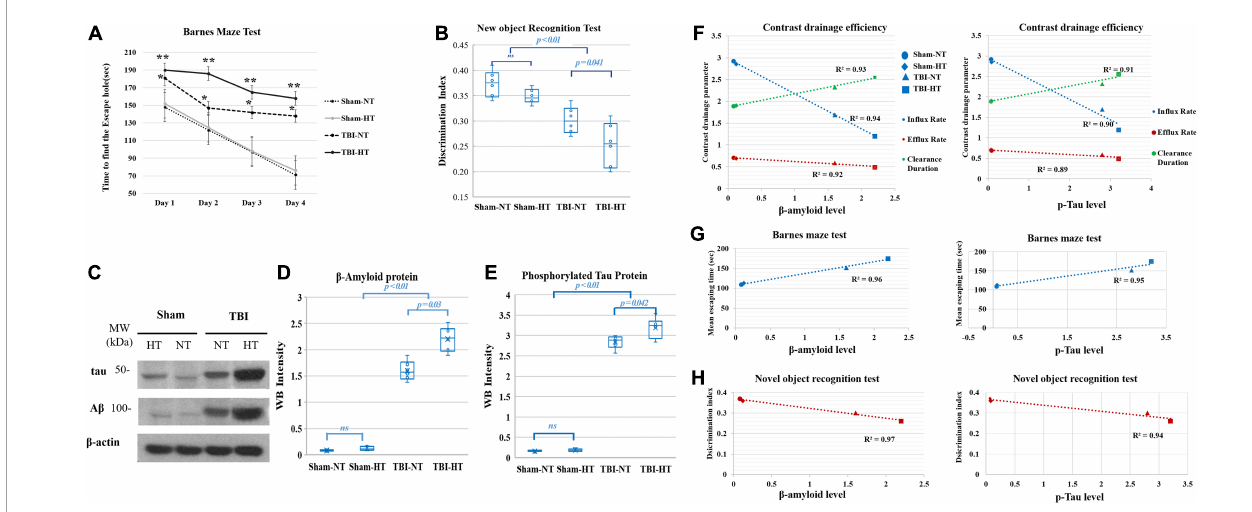
FIGURE6 Cognitive function was evaluated with the novel-object recognition test (A) and the Barnes maze test (B) . In both trials, TBI-HT and TBI-NT rats showed impaired cognitive performance compared with sham controls (* p < 0.05, TBIs vs. sham and TBI-HT vs. TBI-NT, n = 8–12 animals per group). Posttraumatic cognitive impairment was exacerbated in the hypothermic TBI rats compared with the normothermic TBI rats (** p < 0.05 TBI-HT vs. TBI-NT, n = 12 animals per group). (C) Western blot analysis shows obvious beta-amyloid and p-tau accumulation in rat brains 1 month after TBI and hypothermia. Quantitative analysis shows significantly increased β -amyloid (D) and p-tau (E) deposition in TBI-HT and TBI-NT rats compared with sham controls (Mean ± SD, one-way ANOVA with Bonferroni’s post-hoc test for multiple comparisons; n = 4–6 animals per group, n.s.: not significant). The correlation between p-tau and β -amyloid accumulation with glymphatic dysfunction and cognitive deficits is described in box plot graphs (F–H) . Box plot graphs (F) show that the amyloid β and p-tau levels in the brains of sham control, TBI-NT, and TBI-HT rats were inversely linearly related to the reduced influx and efflux rate and linearly related to the increased clearance constant of high-molecular-weight contrast transported along with perivascular spaces (pineal and pituitary recess and periarterial space of the olfactory artery) in the four groups ( r 2 = 0.94, 0.92, 0.93 for amyloid β level and r 2 = 0.90, 0.89, 0.91 for tau level and the influx rate, efflux rate and clearance constant, respectively, all p < 0.01, Spearman’s correlation test, n = 20). Scatter plot graphs (G,H) show that the amyloid β and p-tau levels in the brains of the four groups are linearly related to their increased mean escape time in the Barnes maze test (amyloid β : r 2 = 0.96, p-tau: r 2 = 0.95, p < 0.01, Spearman’s correlation test, n = 20) and inversely linearly related to their decreased discrimination index in the novel object recognition test (amyloid β : r 2 = 0.97, p -tau: r 2 = 0.94, p < 0.01, Spearman’s correlation test, n = 20).